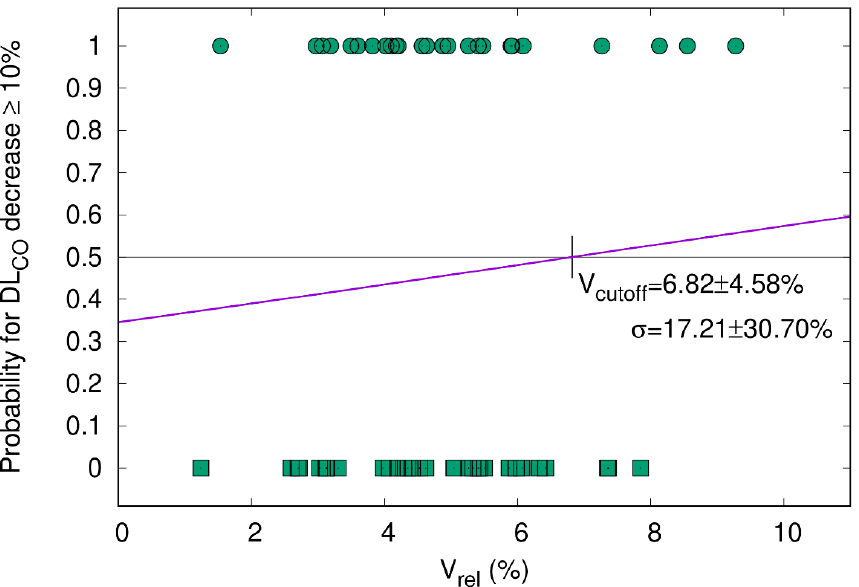
Figure 5. Patients with ICI (=immune checkpoint inhibitor). The probability of DL CO decrease ≥ 10% after the end of RT (y-axis) is plotted as a function of the relative size of V 65–45% with respect to the total lung volume (V rel , x-axis). The cumulative distribution function (CDF) does not reveal a significant correlation. Patients had paired measurements before and three months after radiotherapy ( n = 56, Pearson correlation coefficient = − 0.001, p -value = 0.498). Patients with a DL CO decrease of ≥ 10% and <10% are represented by circles and squares, respectively.